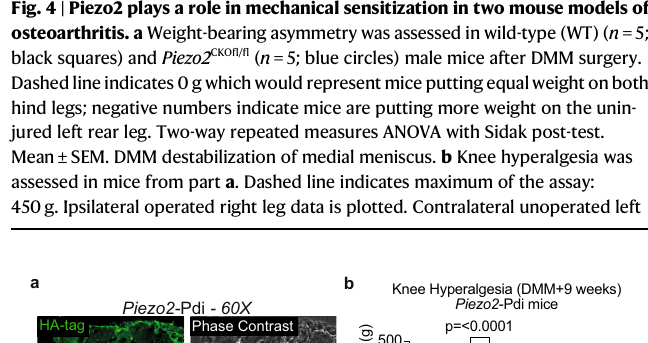
Fig. 5 | Silencing Piezo2+ neurons transiently reverses knee hyperalgesia. a Piezo2-Cre +/ − ;Pdi fl /+ mice express the inhibitory DREADD receptor on dorsal root ganglia (DRG) neurons. Representative images showing immuno fl uorescence for the HA-tagged DREADD receptor. Scale bar=25 µ m. Piezo2-Pdi mice ( n =6, 22 – 31 weeks old). b Knee hyperalgesia in male Piezo2-Cre +/ − ;Pdi fl /+ inhibitory DREADD mice 9 weeks after DMM surgery was assessed before, 1, 2, and 4h after intra-articular injection of saline ( n =10 mice; black squares) or CNO ( n =9 mice; bluecircles).Dashedlineindicatesmaximumoftheassay:450g.Two-wayrepeated measuresANOVAwithSidakpost-test.Mean±SEM.DMMdestabilizationofmedial meniscus, CNO Clozapine-N-oxide. HA hemagglutinin. ‘ Designer Receptors Exclu- sivelyActivatedbyDesignerDrugs ’ =DREADD.For b ,sourcedataareprovidedasa Source Data fi le.